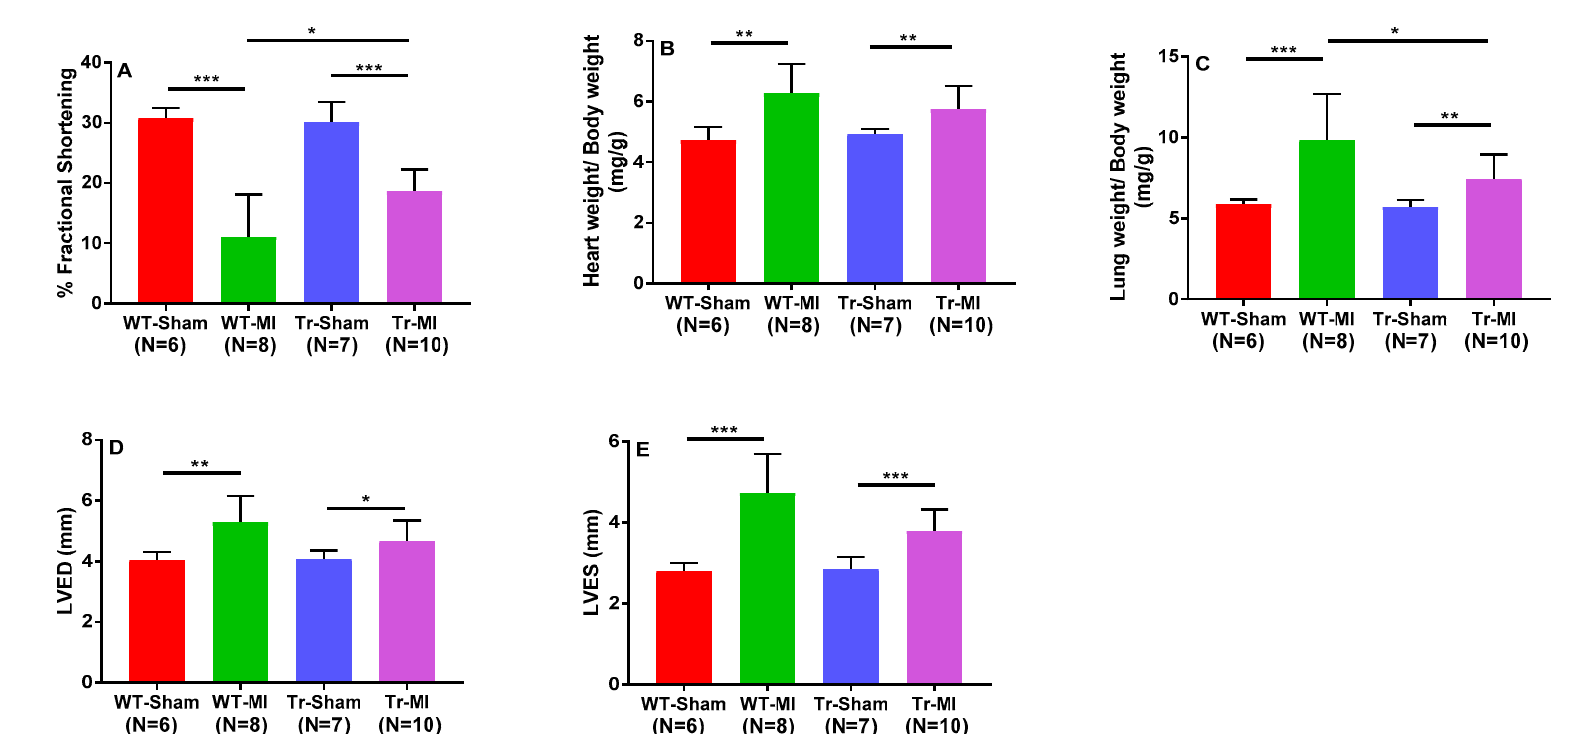
Figure 6. Echocardiographic measurement of ventricular function following myocardial infarction (MI). ( A ) Percentage fractional shortening (%FS), an indicator of contractile function of the left ventricle; ( B ) heart weight to body weight (HW / BW) ratio; ( C ) lung weight to body weight (LW / BW) ratio; ( D , E ) measurement of the left ventricle dimensions at the end of diastole (the biggest cardiac dimension, LVED, D) and systole (the smallest cardiac dimension, LVES, E) in mice subjected to sham or MI surgery. * Indicates p < 0.05, ** p < 0.005, *** p < 0.0005.